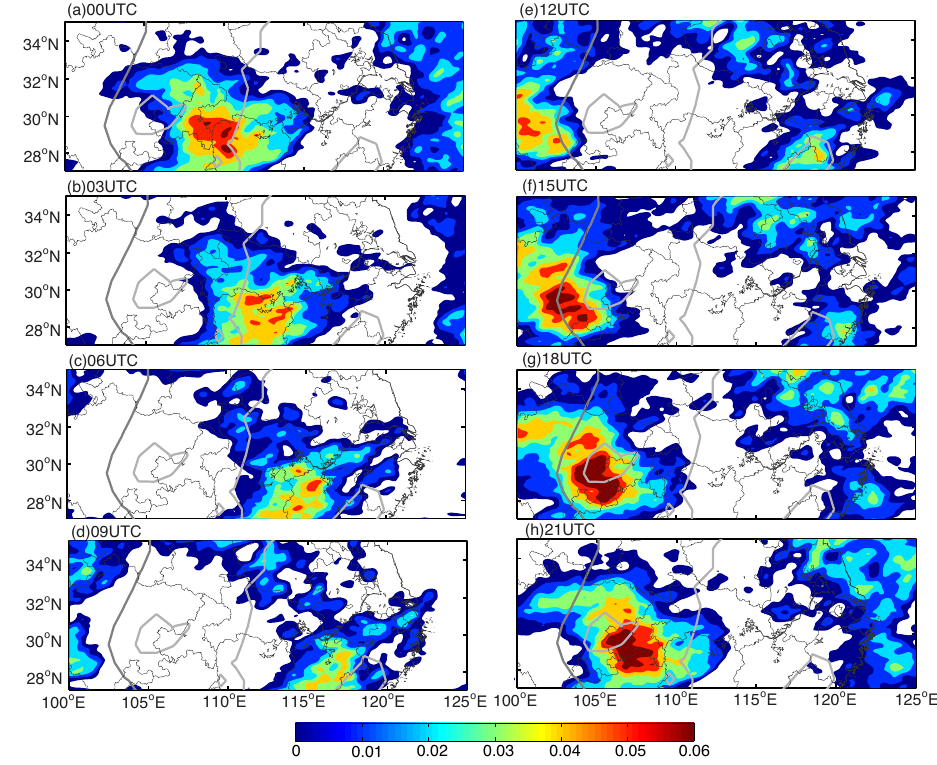
Figure 11. Similar to Fig. 3 but for the filtered precipitation perturbations (units: mmh − 1 ) over the spectral range, bounded by the phase speed between 10 and 25ms − 1 over East Asia.